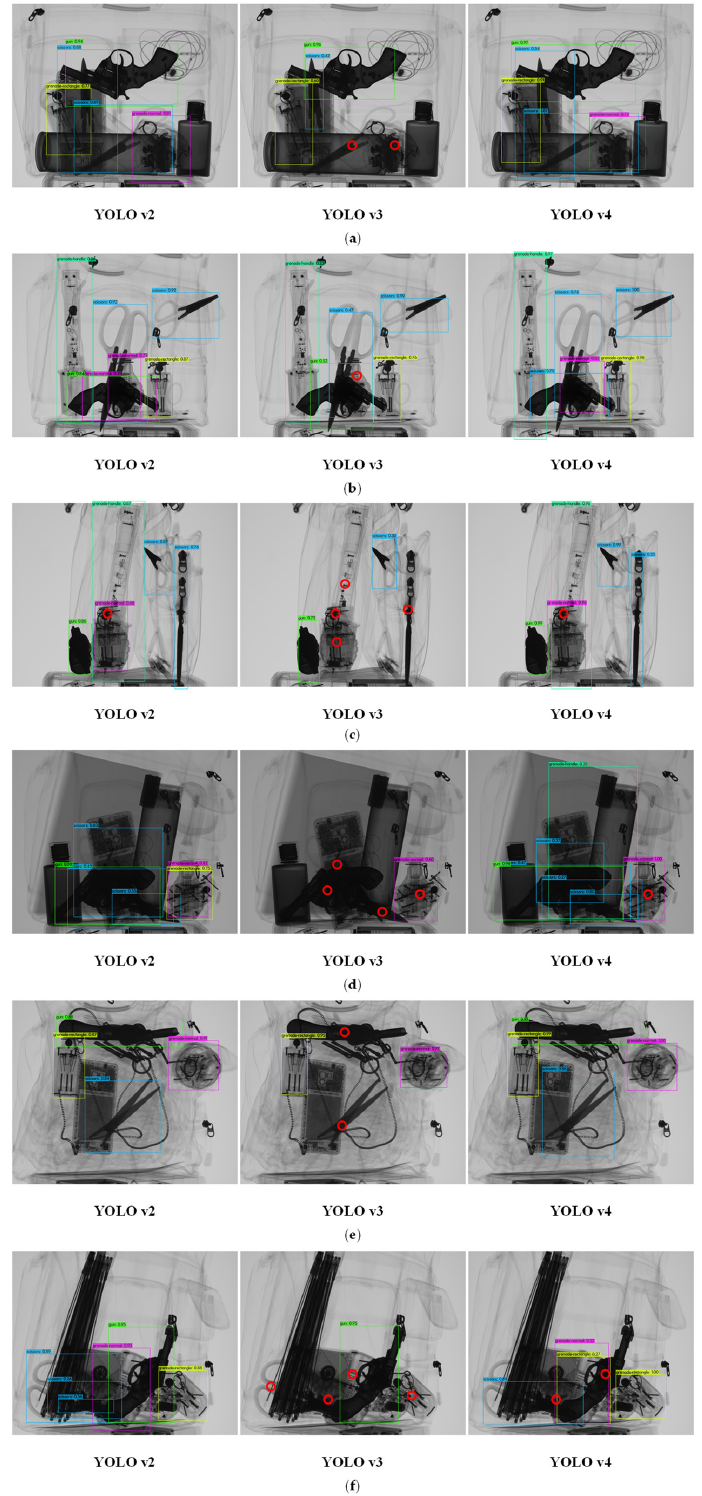
Figure 12. Comparison of detection results: ( a ) test group 1; ( b ) test group 2; ( c ) test group 3; ( d ) test group 4; ( e ) test group 5; ( f ) test group 6. (The red circles mark dangerous goods that were missed).